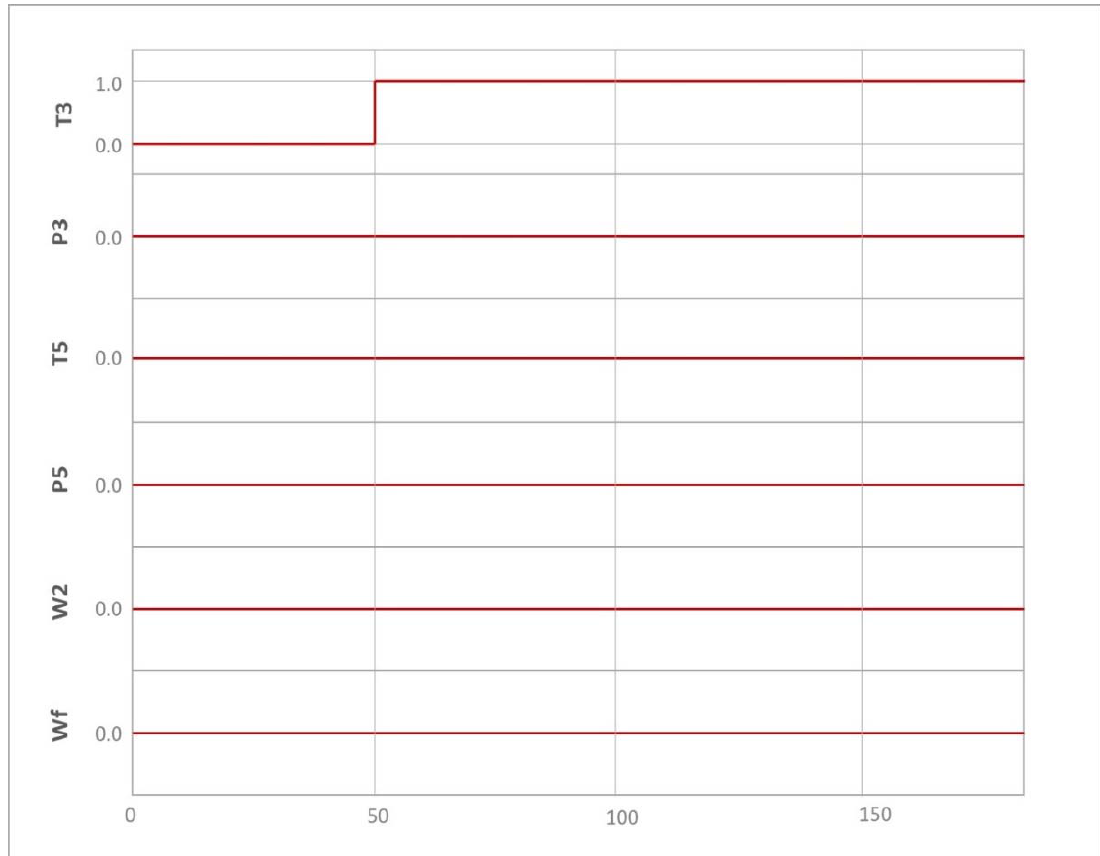
Figure 14. BN predictions of sensor status in Scenario 3 for T3 sensor fault. 0 means no fault and 1 means fault.